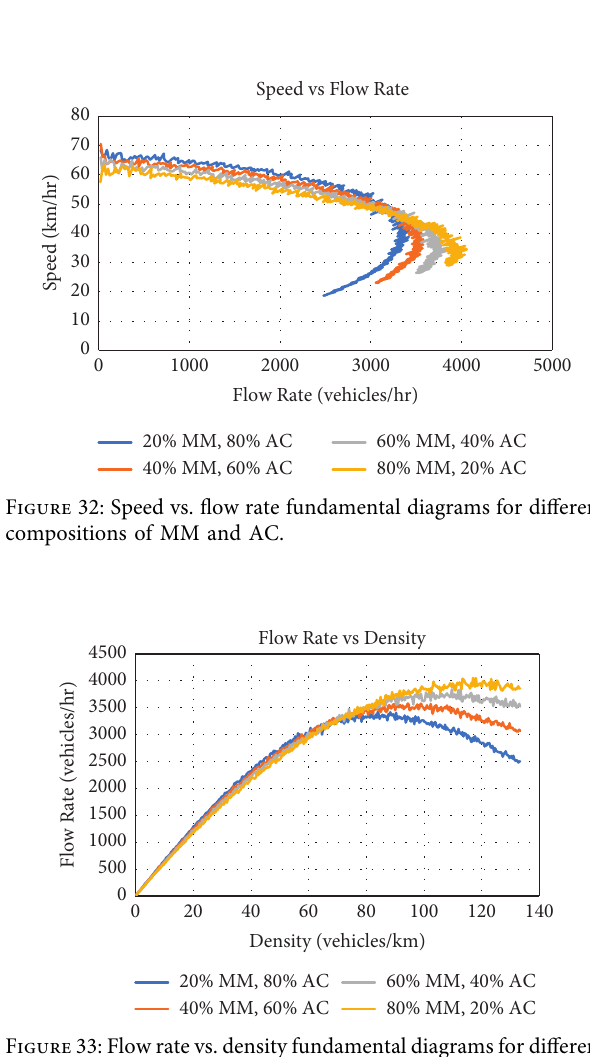
Figure 31: Speed vs. density fundamental diagrams for different compositions of MM and AC.